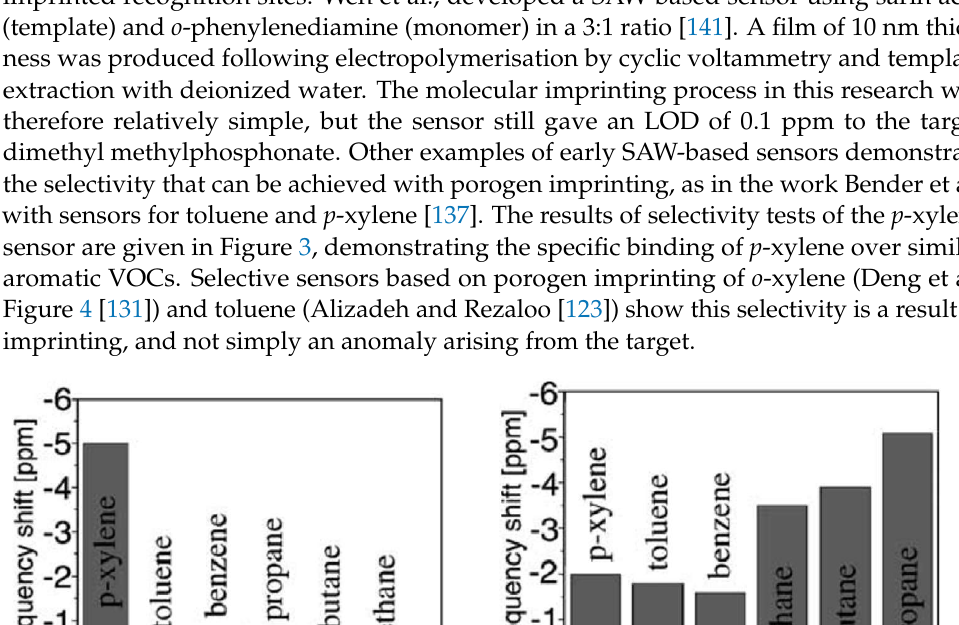
Figure 4. Results of Deng’s selectivity studies in analysis of a porogen imprinted polymer for o− xy- lene. MIPs were produced using divinylbenzene as functional monomer and crosslinker, and o− xy- lene was used as template and solvent. The resulting monolith was ground, dispersed in o− xylene and cast onto a quartz crystal to give a gravimetric sensor. Reproduced with permission [131]. In the latter example of Alizadeh and Rezaloo, the dynamic range of this sensor was 3.8–46.4 ppm and the limit of detection was 0.8 ppm. It also involved an electrochemical method, which may be preferable to the mass sensing methods previously described. Porogen imprinting in electrochemical sensors typically relies on polymer swelling in the presence of the target molecule, often aided by the addition of conductive nanomaterials. Early studies suggested that dependence on this mechanism may cause problems with sensor consistency due to polymer deformation on repeated use [194]. This is apparently a concern primarily with polymer films, where porogen imprinting is likely to give a uni- form featureless surface [189]. Such materials are more susceptible to stresses of swelling and provide a relatively low surface area. More common therefore is the use of micro- scopic porogen imprinted polymer spheres with the conductive material. An illustration is given in Figure 5 [82]. Cheap conductive materials such as carbon black may be used for this purpose. More sophisticated methods involving very small nanoparticles (10 nm) and carbon nanotubes may give sub-ppm sensitivity and high selectivity [57].